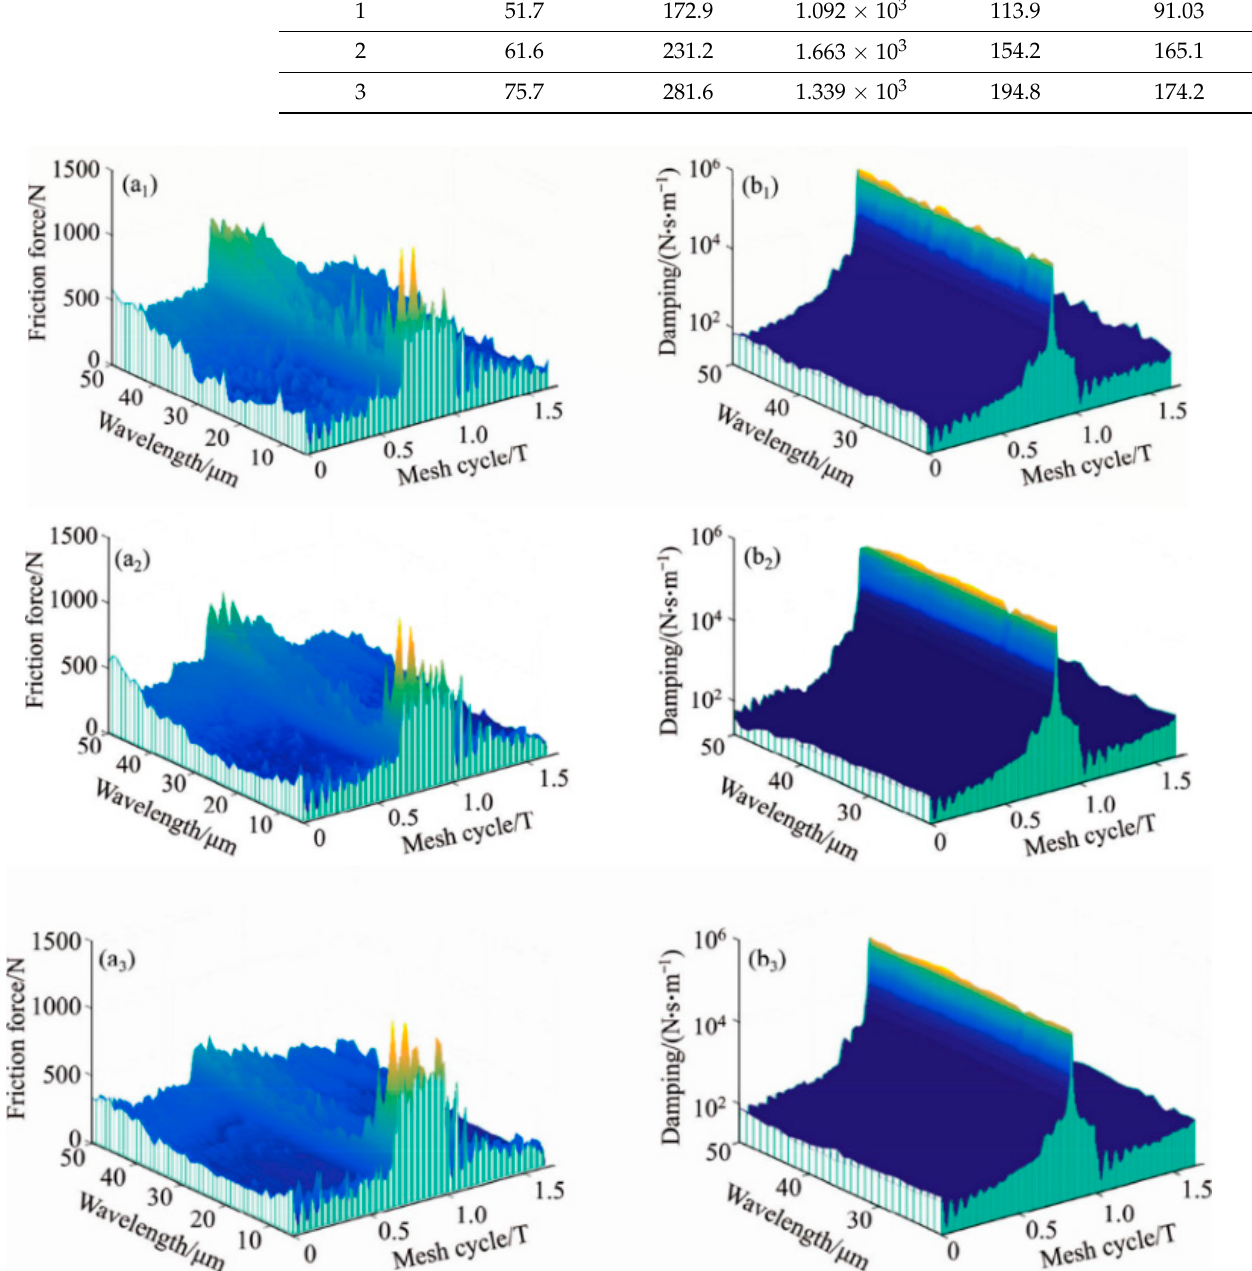
Table 3. Viscous damping values of 5 specified points in a meshing period under cases. Cases